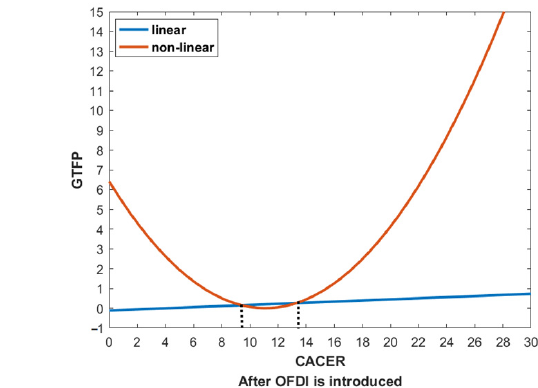
Figure 5. The inflection points for the impact of CACER on GTFP in eastern China.